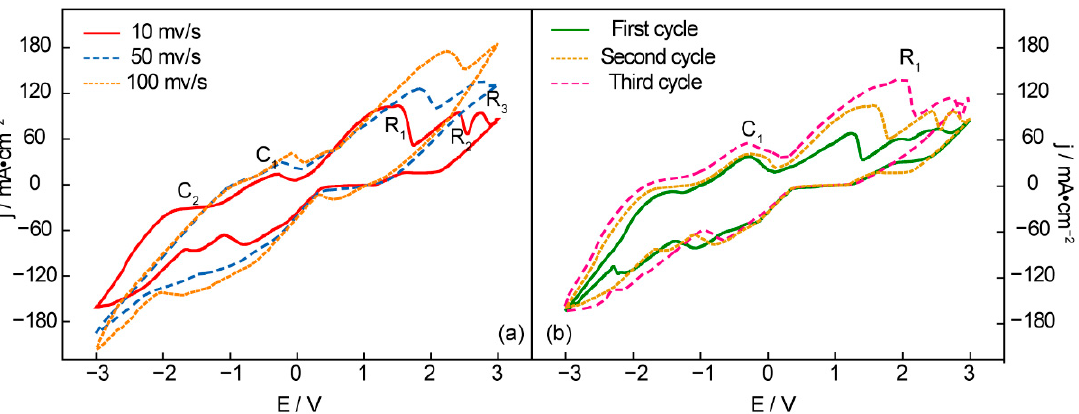
Figure 1. Cyclic voltammetry recorded from an Ni anode and Fe cathode in Li 1.43 Na 0.26 K 0.21 CO 3 at 550 °C under consecutive cycling ( a ) in different scanning rates and ( b ) different scanning cycles at 10 mv/s.